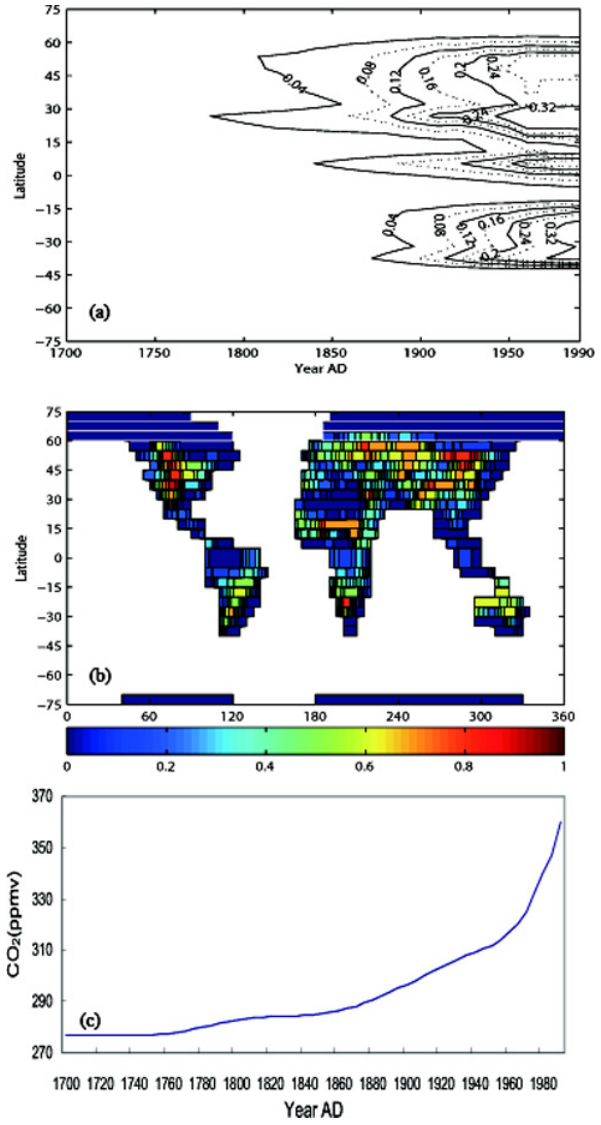
Fig. 1. Dynamics of climate forcings used in the simulation. (a) Zonally averaged changes in the cropland and pasture fraction from year 1700; (b) cropland and pasture map in year 1990; (c) CO 2 concentration in the